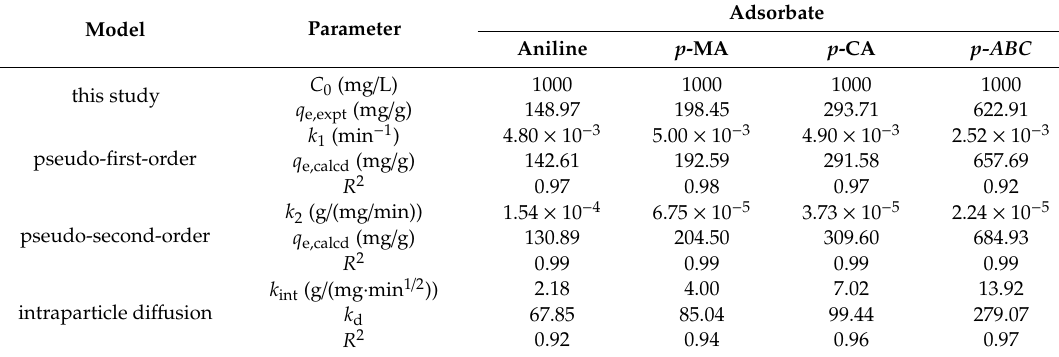
Table 1. Kinetic parameters for the adsorption of aniline compounds on the CDM-HCP at 20 ◦ C.